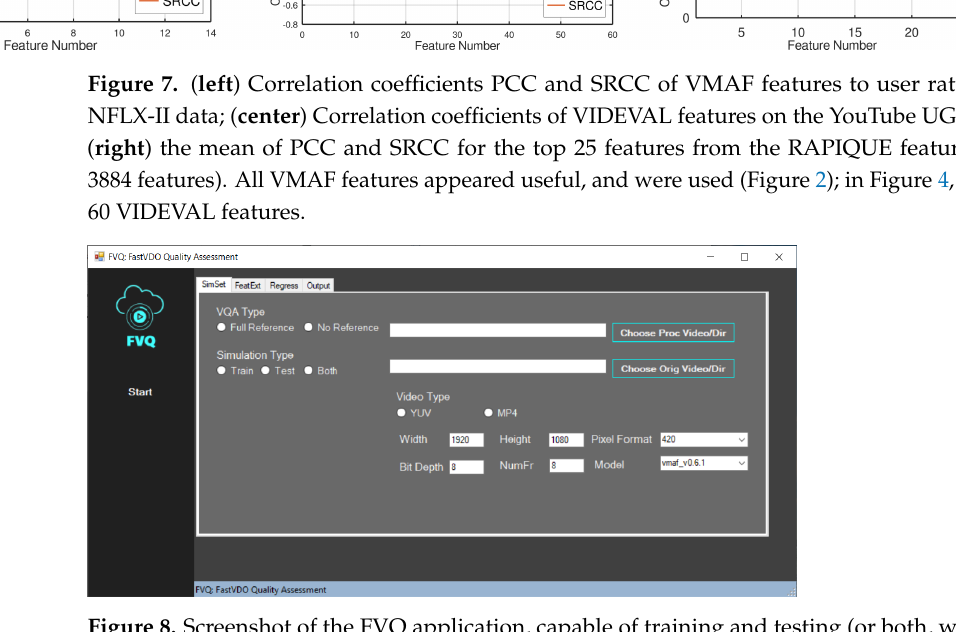
Figure 8. Screenshot of the FVQ application, capable of training and testing (or both, with random split), and computing VMAF as well as FVSVR and FVNN VQA scores, with parameter